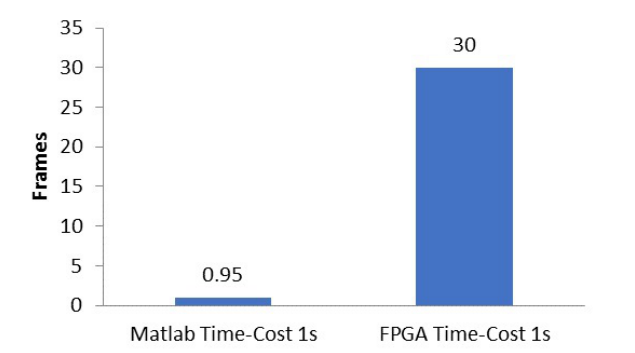
Figure 9. Comparing computational costs of MATLAB and FPGA